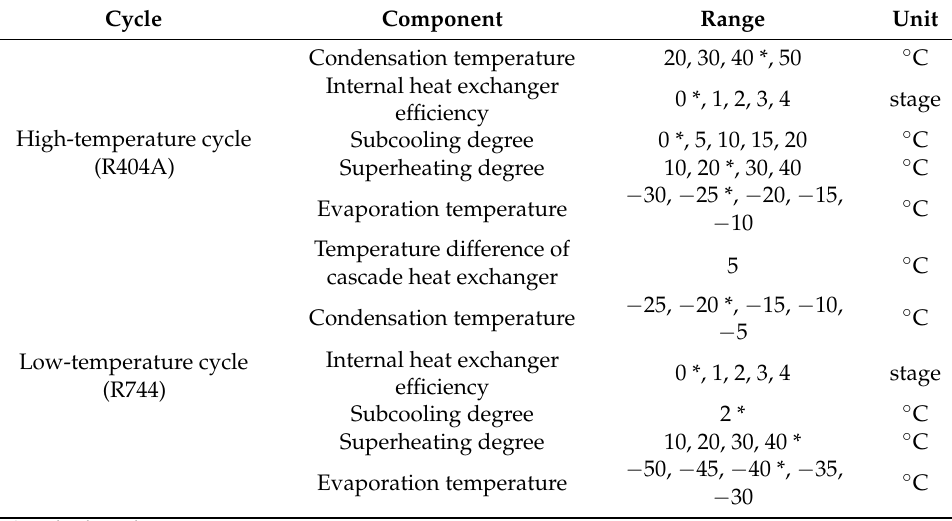
Figure 2. Schematic diagram of experimental apparatus for the CRS using R744. [13]. Table 2. Experimental conditions of the CRS [13].